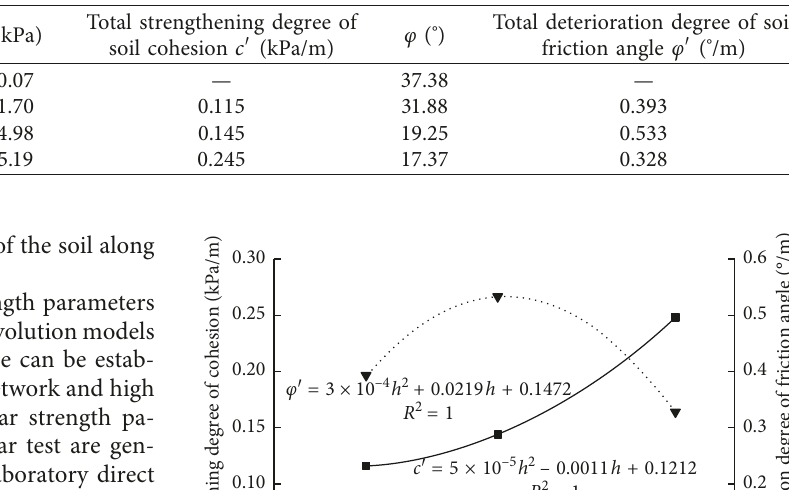
Table 7: Synthetic shear strength parameters.